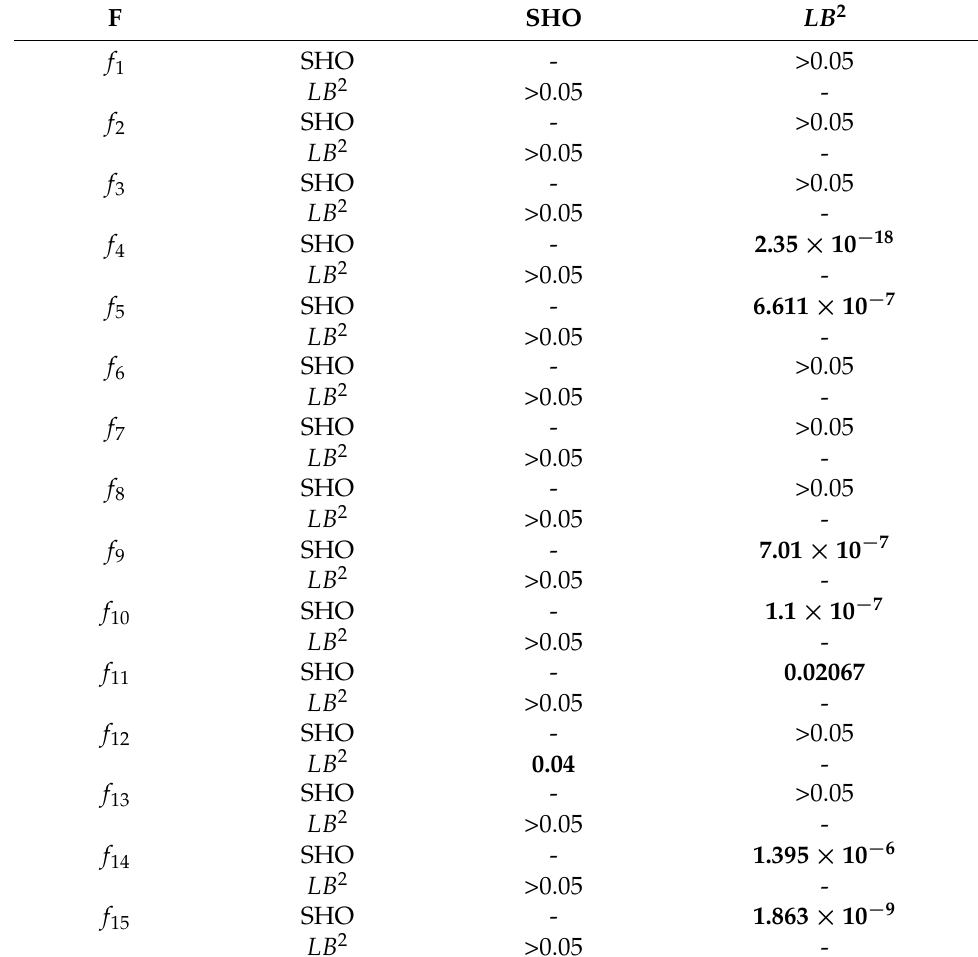
Table 13. Exact p values obtained on the benchmark test